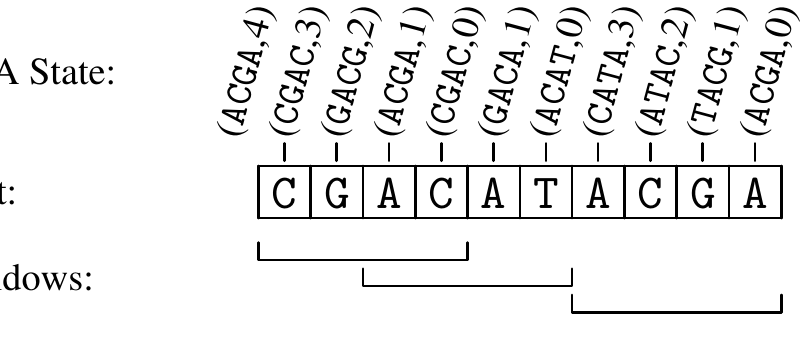
Figure 2. Illustration of the DAA encoding the behavior of Horspool’s algorithm when searching the text s = CGACAT ACGA for the pattern p = ACGA . On top, one sees the state the DAA takes after reading the character below. The leftmost state is the start state. At the bottom, the windows considered by Horspool’s algorithm are indicated, illustrating that the second component of the current state encodes the distance to the right end of the next